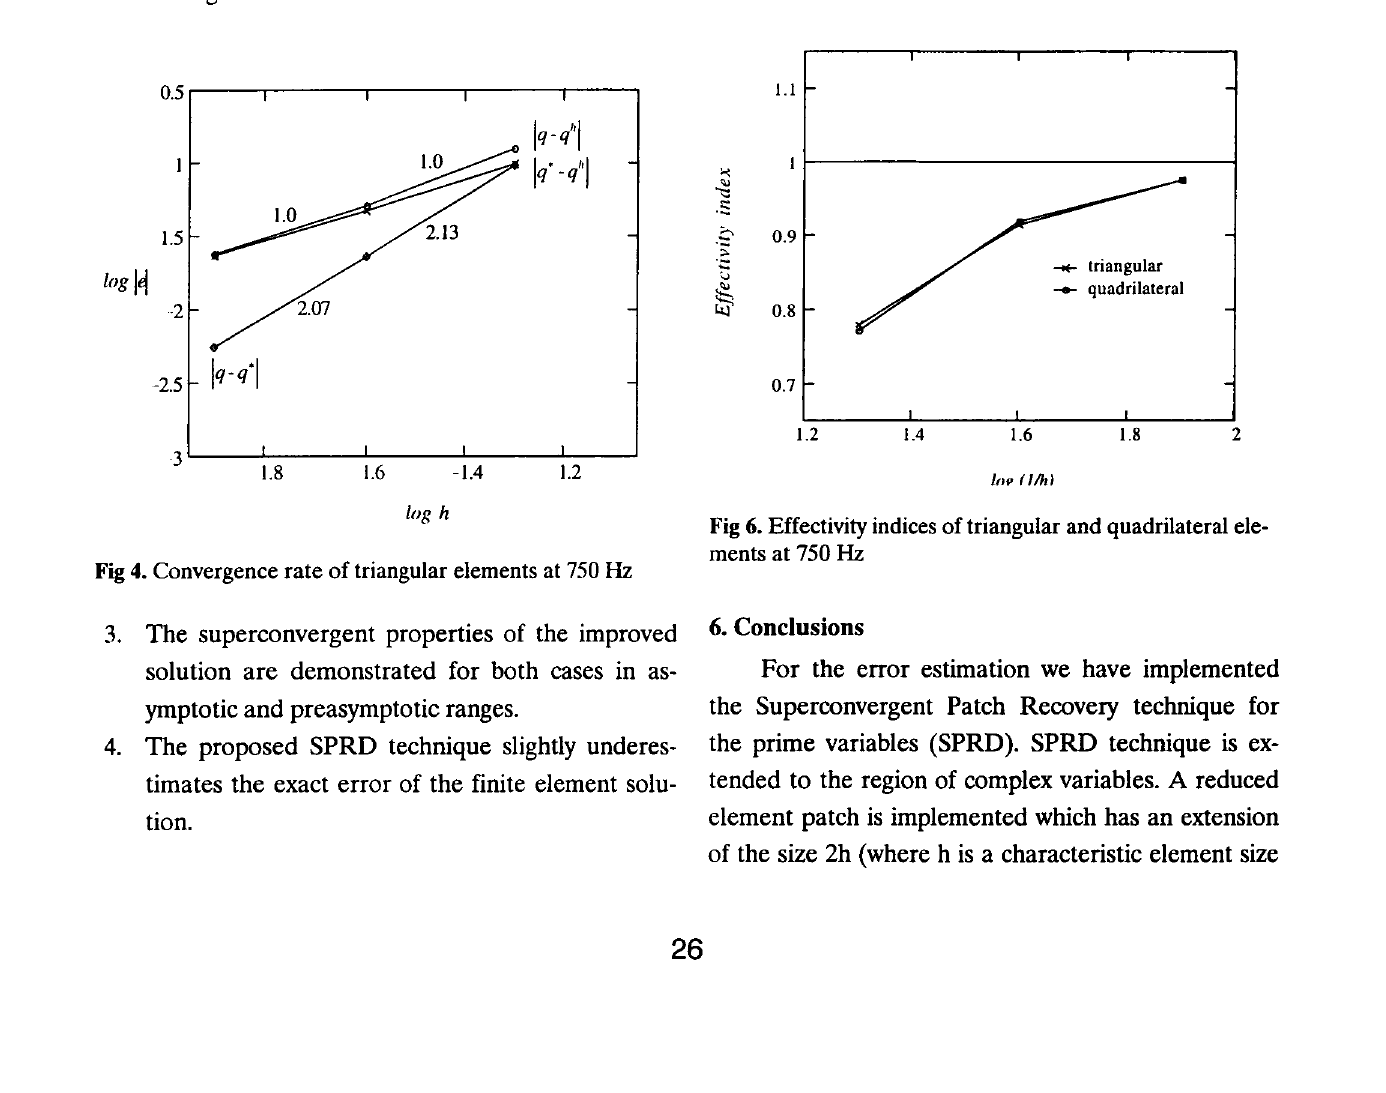
Fig 5. Effectivity indices of triangular and quadrilateral ele ments at 50 Hz The convergences of the effectivity indices are plotted in Figs 5 and 6.